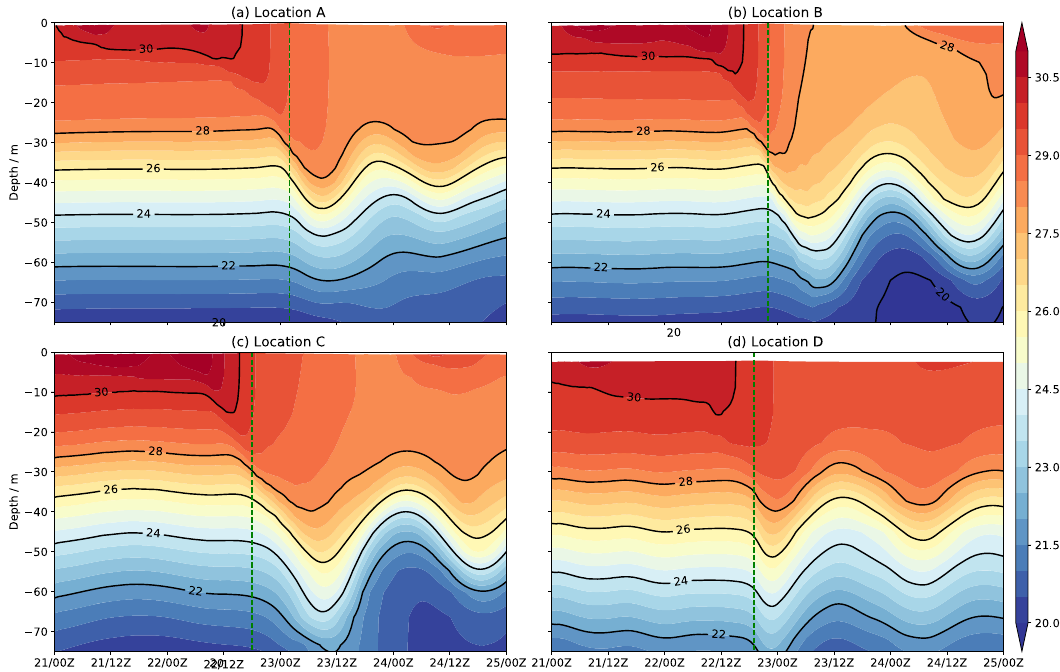
Fig. 3 Cross sections of ocean temperature during the passage of Typhoon Hato. Hovmöller diagrams of vertical ocean temperature pro fi le in °C of the control experiment of Typhoon Hato at the four locations along the edge of continental shelf speci fi ed in Fig. 2a for a left hand side of the track, b over the track, c right hand side of the track, and d deeper ocean. Green dashes represent the closest time of approach to Typhoon